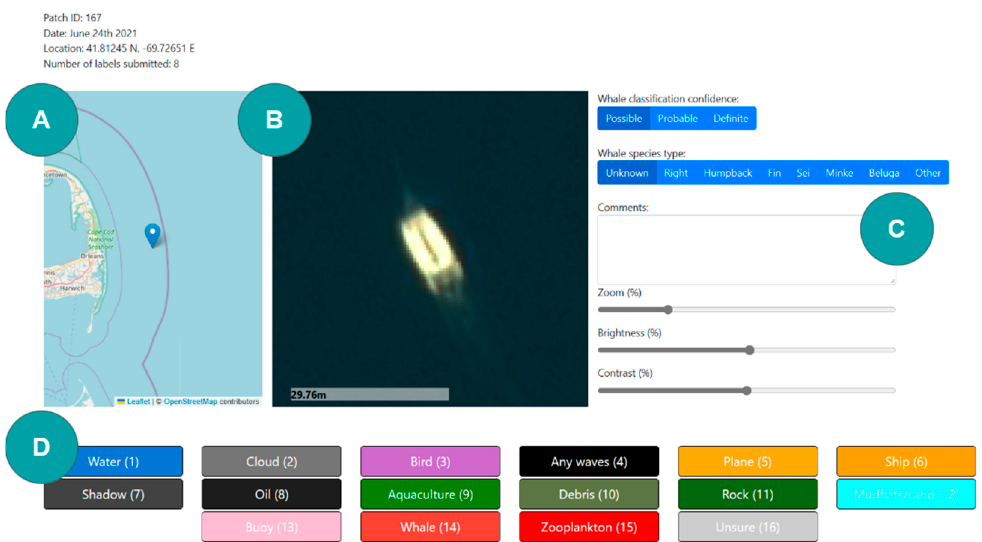
Figure 9. Screenshot of an initial version of the GAIA human-in-the-loop annotation tool. ( a ) Shows where the current point is in a larger spatial context-e.g., the point shown in the screenshot is off the east coast of Cape Cod Bay; ( b ) shows the current image chip to be labeled-these chips are extracted from larger satellite images in an unsupervised manner; ( c ) radio buttons let users select classification confidence and whale species type (if necessary), a comment box allows users to annotate anything additional of interest about each sample, and sliders allow users to adjust the image chip to be labeled (zooming in and out and adjusting brightness/contrast); ( d ) a list of buttons allows users to quickly label each chip-each time a button is clicked the interface will immediately show the next image chip to be labeled.